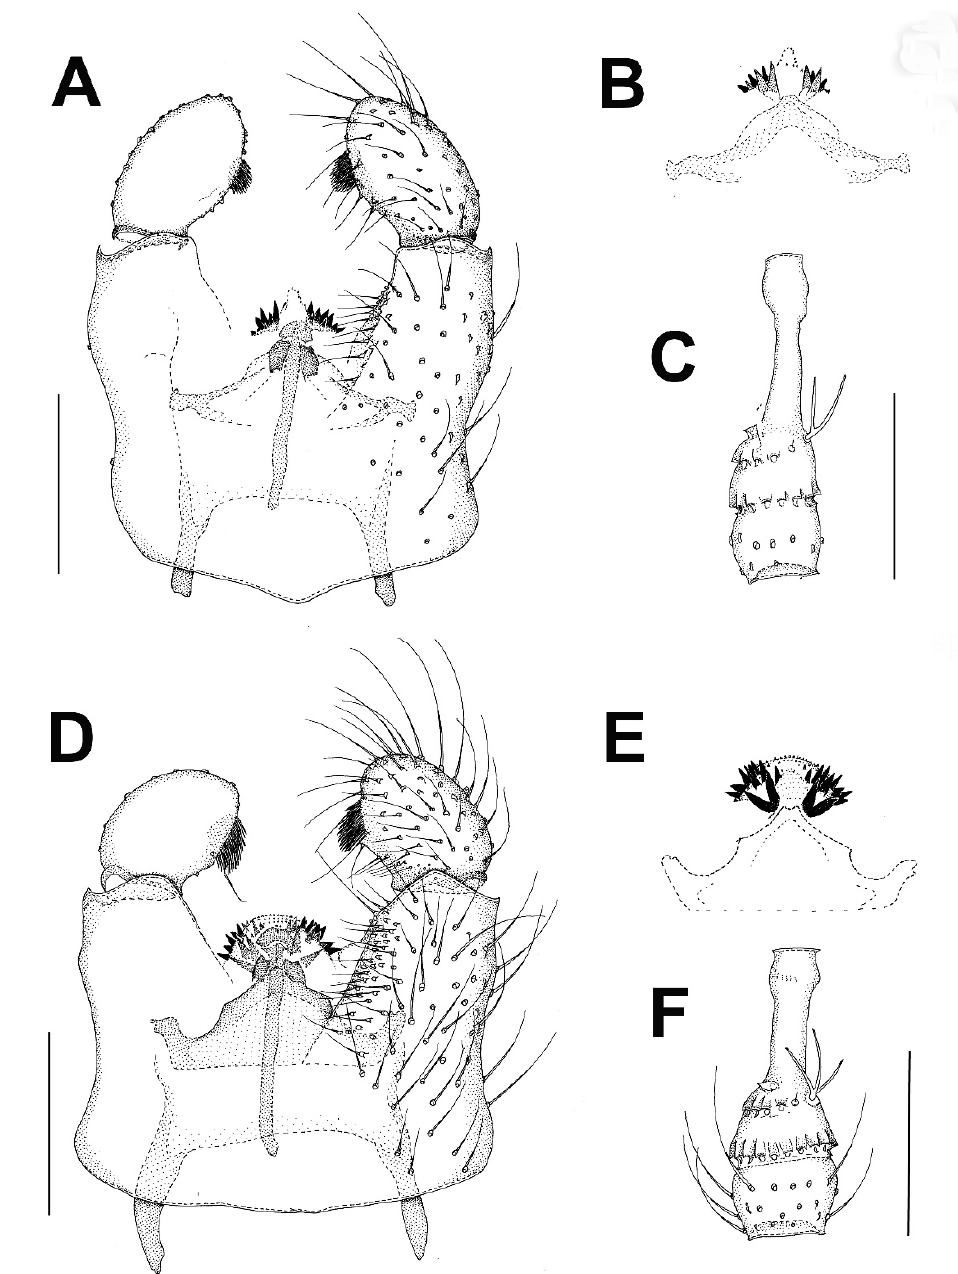
Figure 4. Male terminalia of new species of Cecidomyiidae. Catocha jingfui sp. nov. (holotype), ( A ) ventral view, ( B ) tegmen with associated structures in dorsal view, ( C ) fourth flagellomere; Catocha manmiaoe sp. nov. (holotype), ( D ) ventral view, ( E ) tegmen with associated structures in dorsal view, ( F ) fourth flagellomere. Scale bars: 0.1 mm.